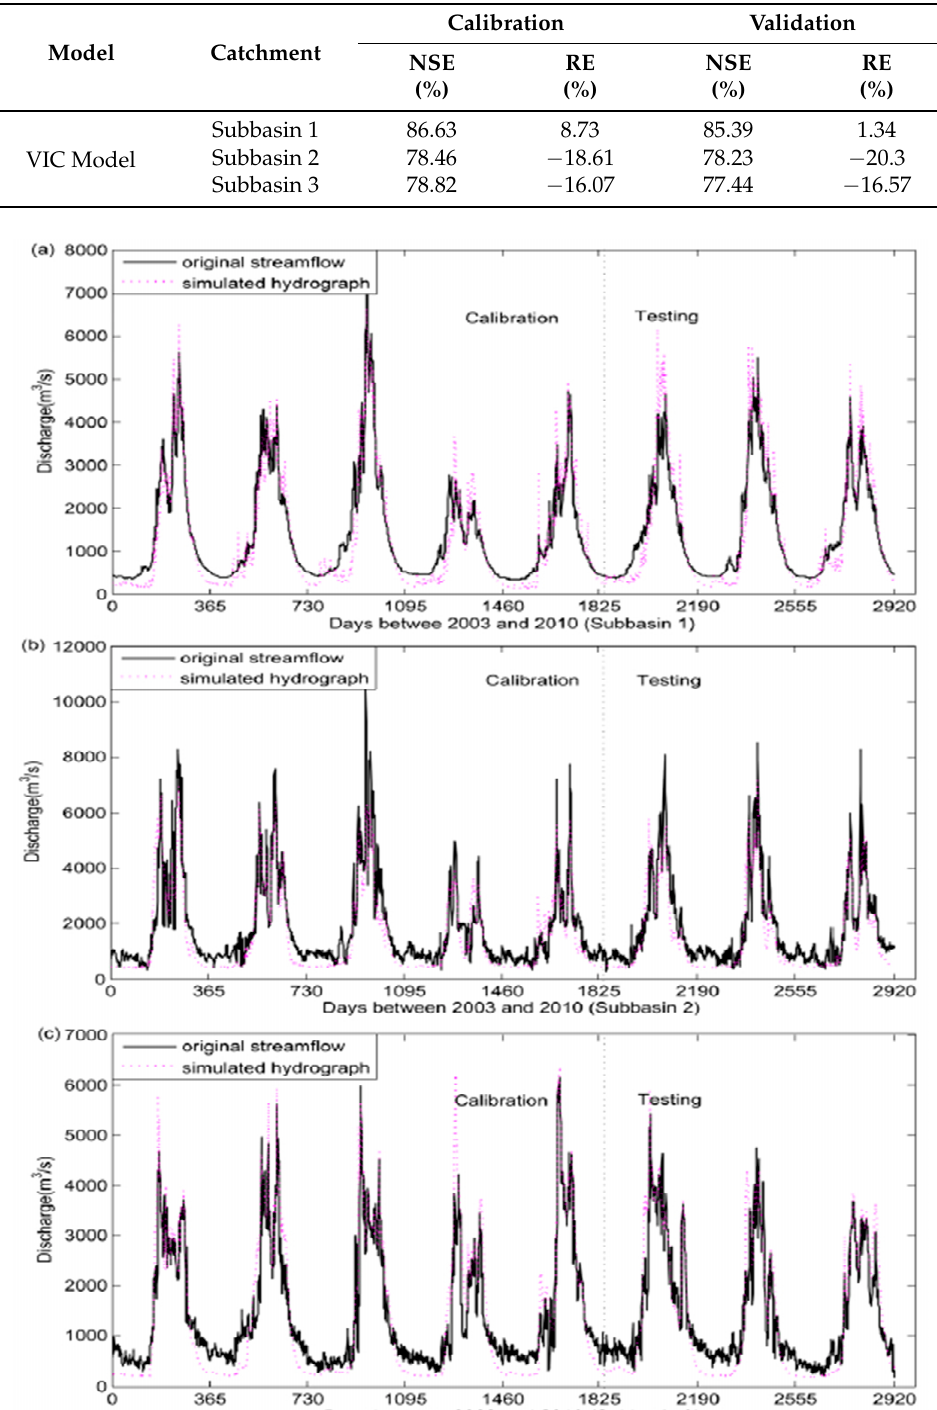
Table 1. Performance of the VIC model in each subbasin.